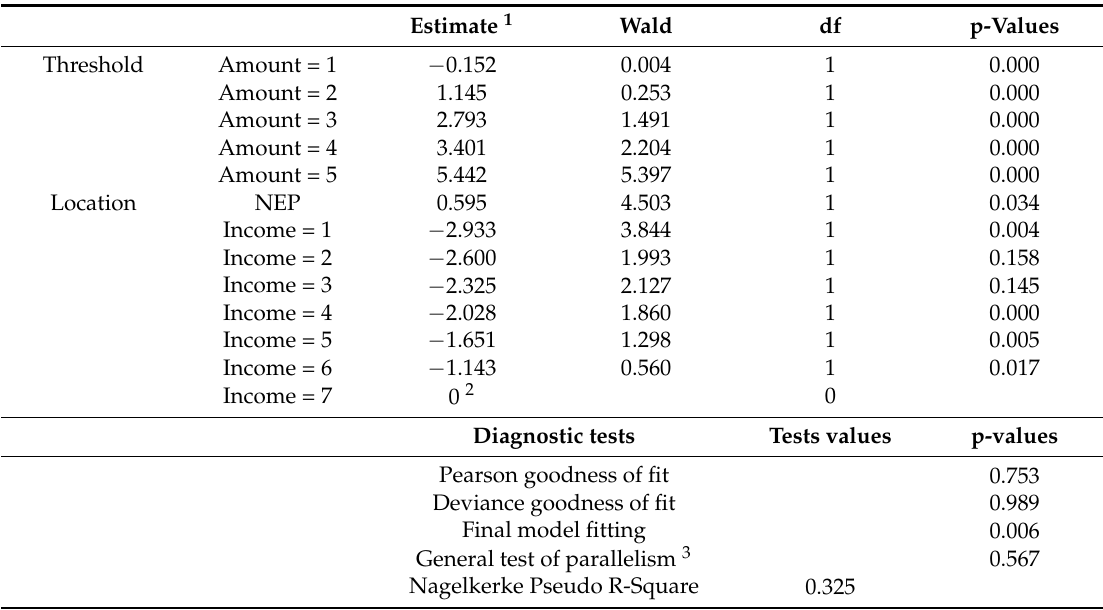
Table 8. Ordinal regression model for the Additional payment “Amount”, parameter estimates and diagnostic